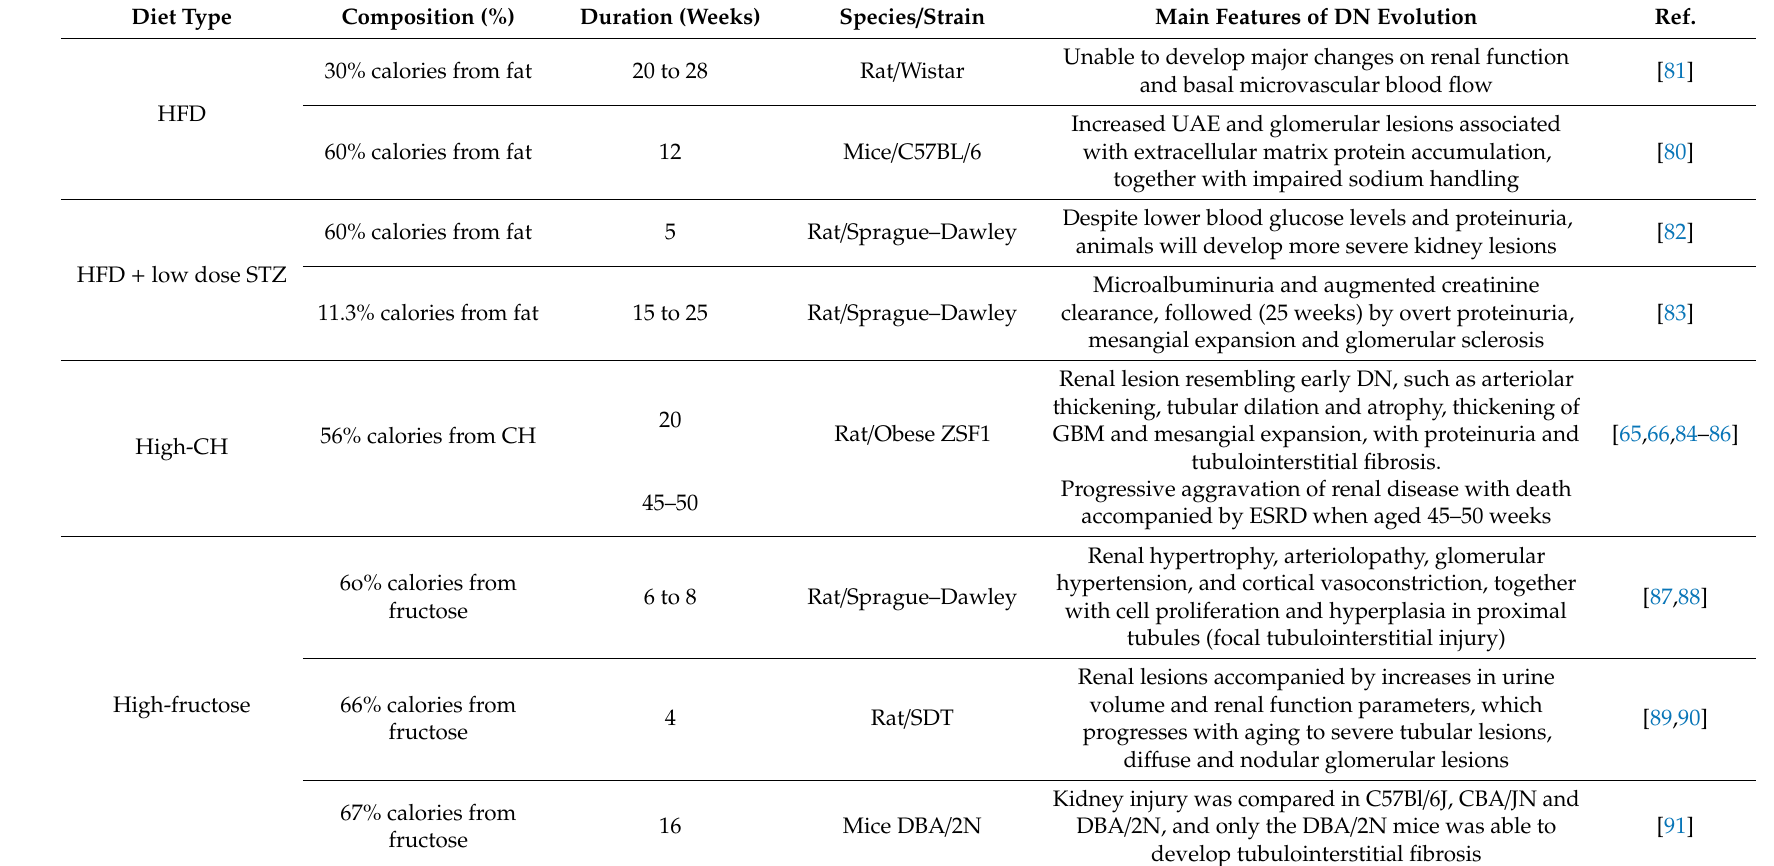
Table 3. Main features of diet-induced rodent models of diabetic